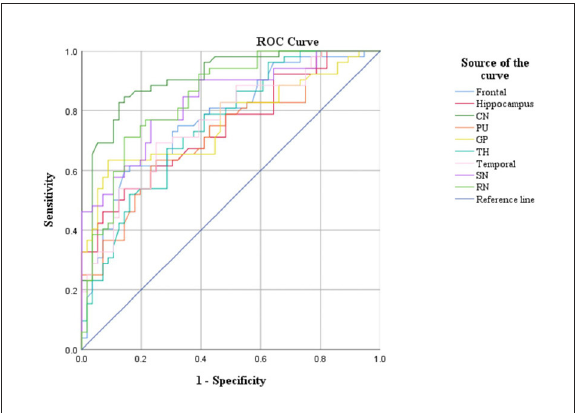
FIGURE2 ROC curve analysis results of iron content in brain